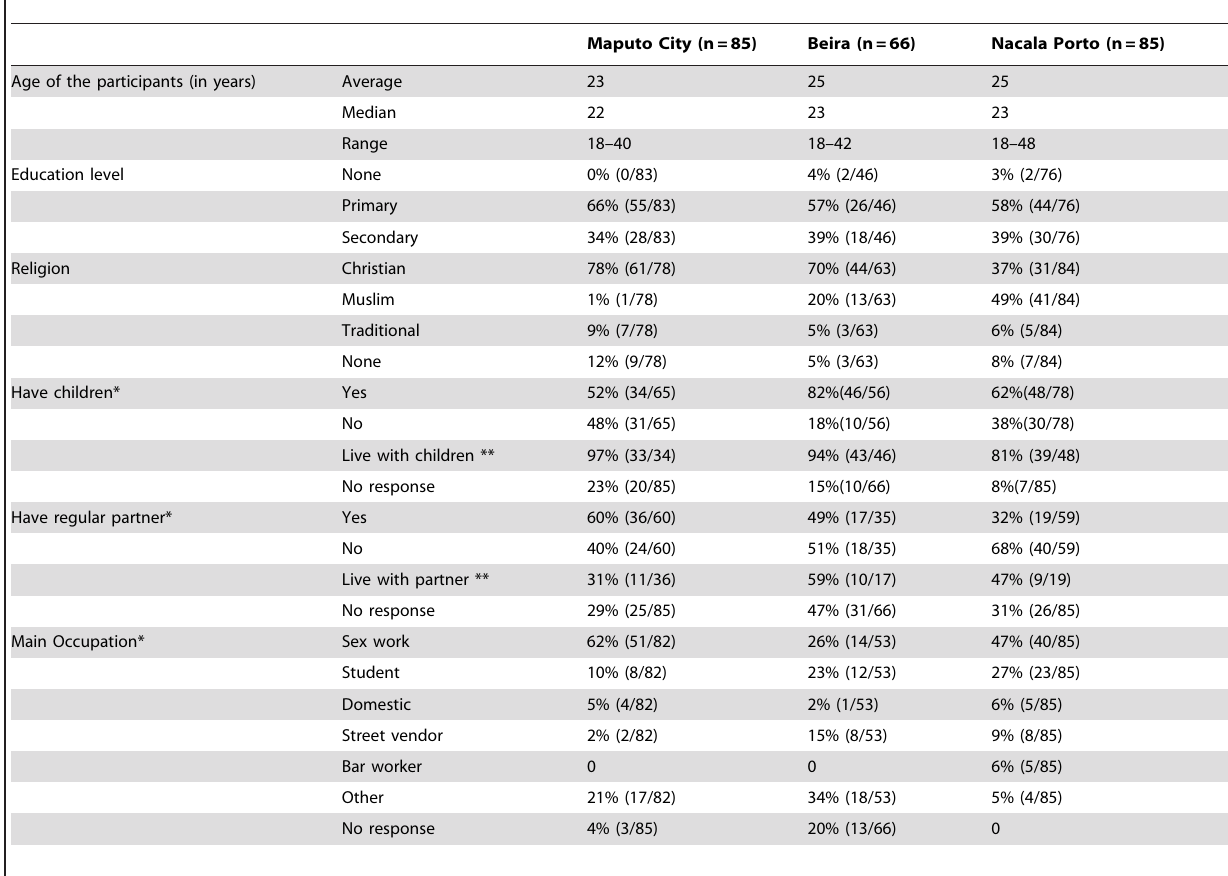
Table 2. Characteristics of all 236 Commercial Sex Workers Interviewed, Mozambique,